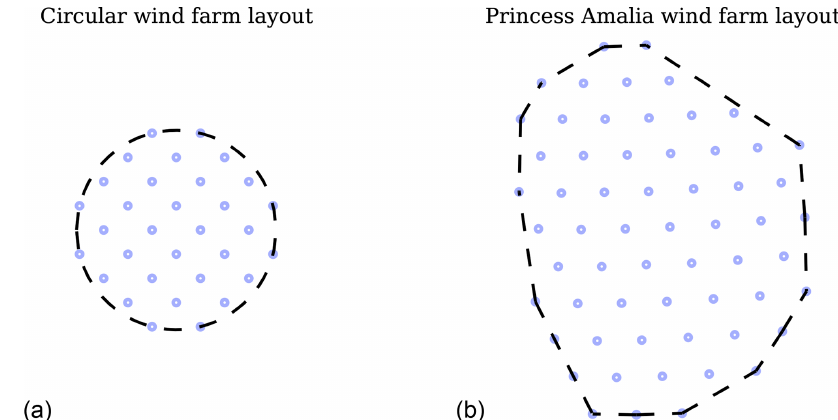
Figure 4. The two different wind farm designs that were optimized: (a) is a contrived circular wind farm design with 32 turbines; (b) is the Princess Amalia wind farm, an offset grid design with 60 wind turbines. The circles representing the turbine locations have a diameter of 80m in this figure, equal to the baseline rotor diameter.